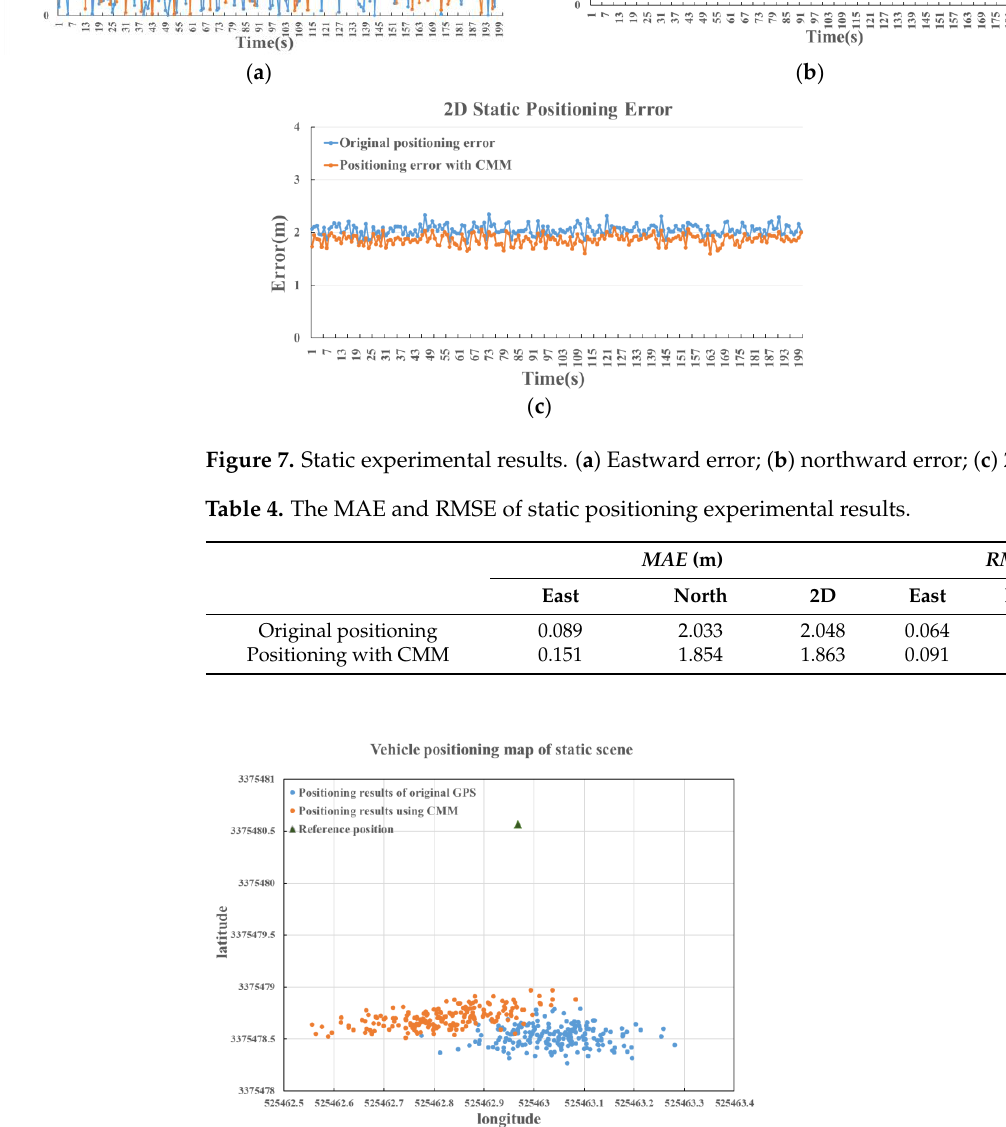
Figure 8. Static positioning of the low-cost positioning system.